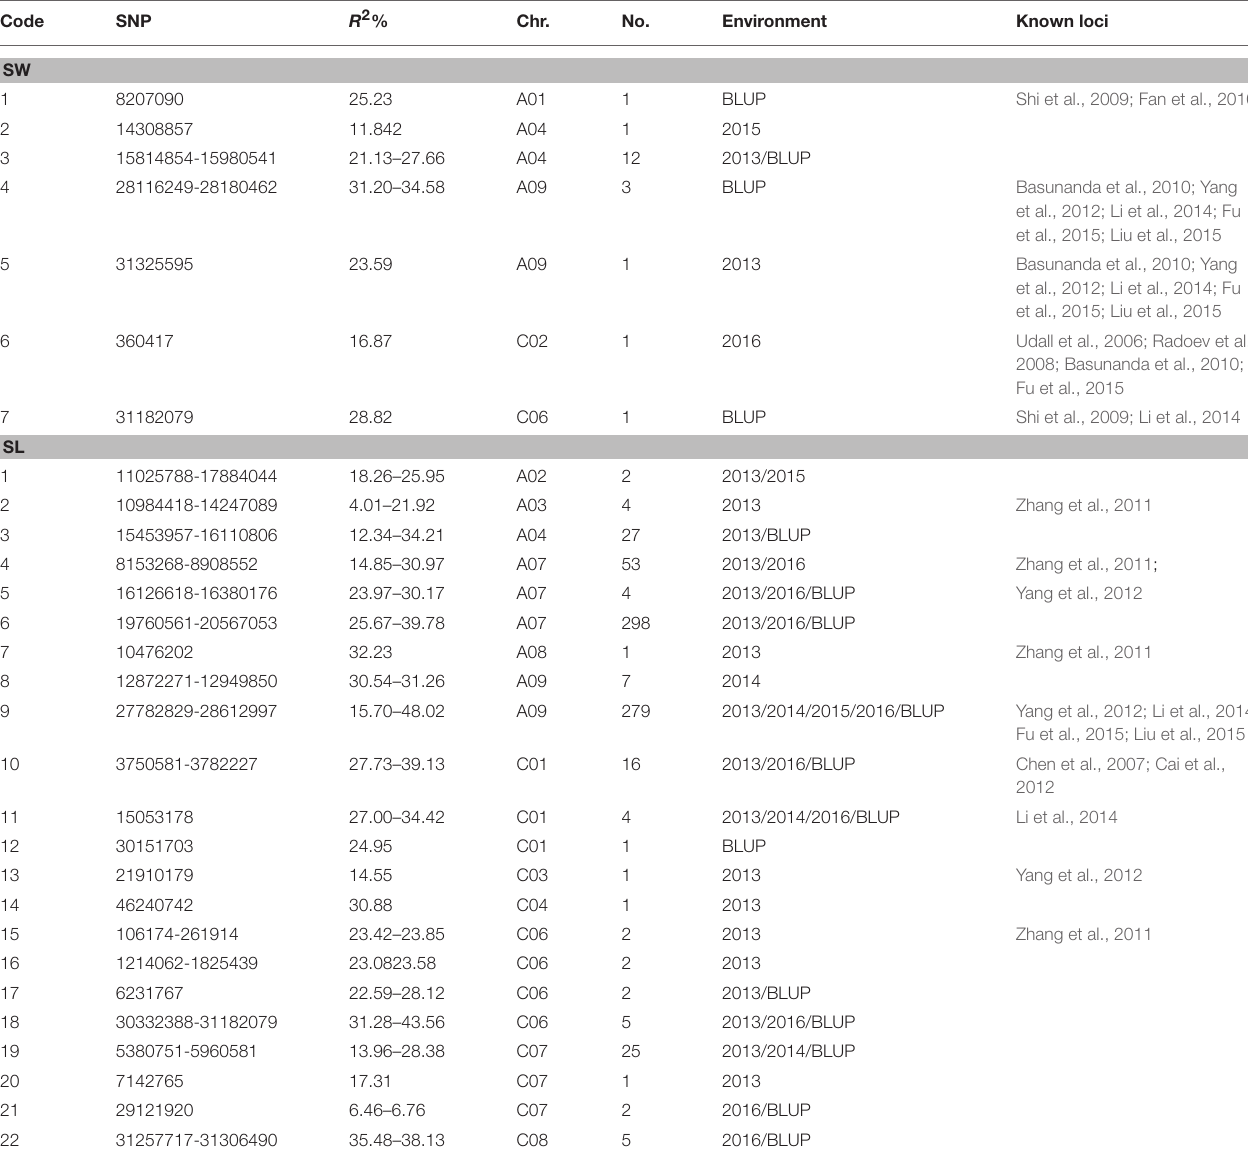
TABLE 3 | List of single nucleotide polymorphisms with significant association with seed weight (SW) and silique length (SL) using 4 years and BLUP field data among 157 rapeseed lines.